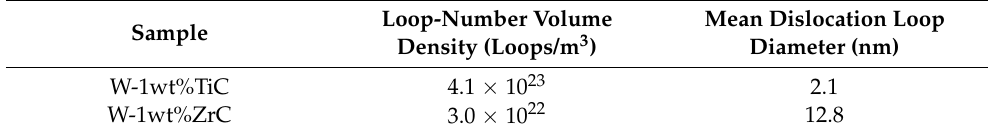
Figure 8. TEM images showing the microstructural evolution in W-1wt%ZrC exposed to 5 keV He + as a function of fluence: ( a ) 1.0 × 10 20 He + /m 2 ; ( b ) 1.0 × 10 21 He + /m 2 ; ( c ) 5.0 × 10 21 He + /m 2 . Table 2. Information on the loop number volume density and mean dislocation loop diameter of W-1wt%TiC and W-1wt%ZrC implanted at 600 ◦ C with 5 keV He + at the fluence of 1.0 × 10 20 He + /m 2